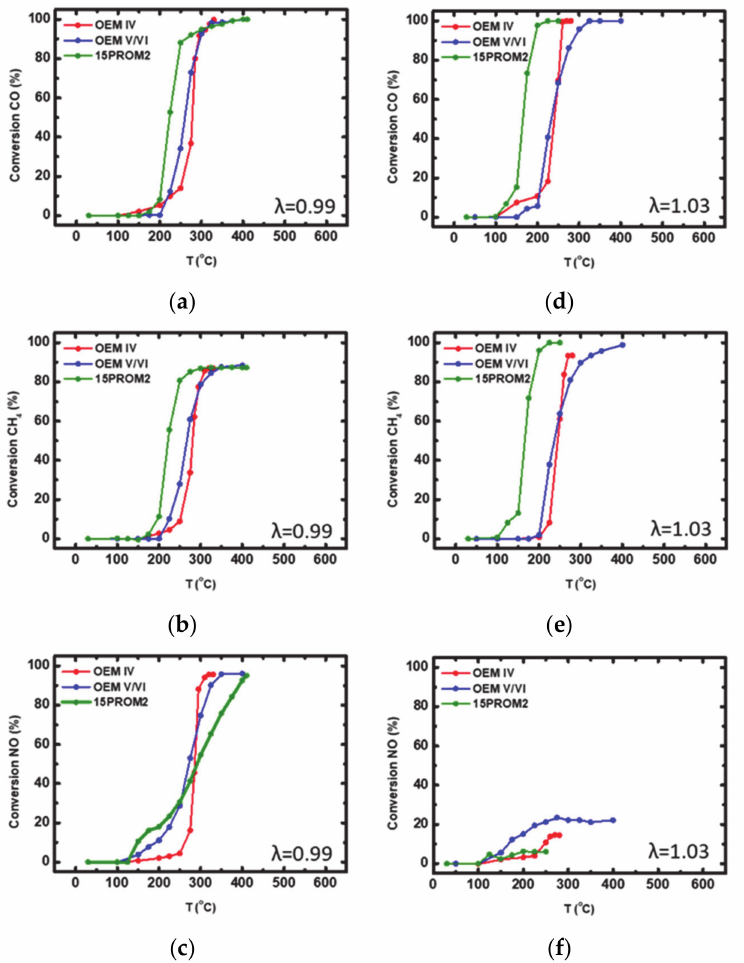
Figure 10. Light-off curves for the (%) conversion of: ( a ) CO; ( b ) CH 4 ; ( c ) NO under rich-burn conditions ( λ = 0.99); ( d ) CO; ( e ) CH 4 ; ( f ) NO under lean-burn conditions ( λ = 1.03) over commercial